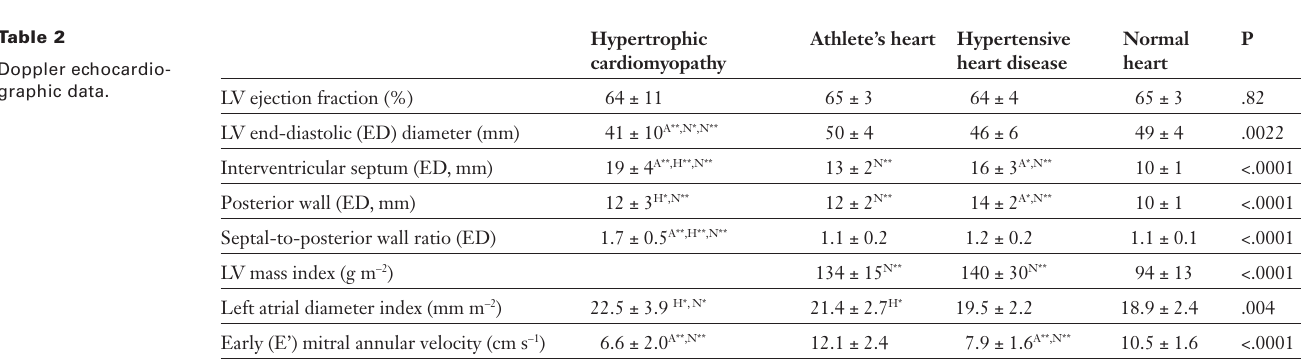
Doppler echocardio- graphic data.